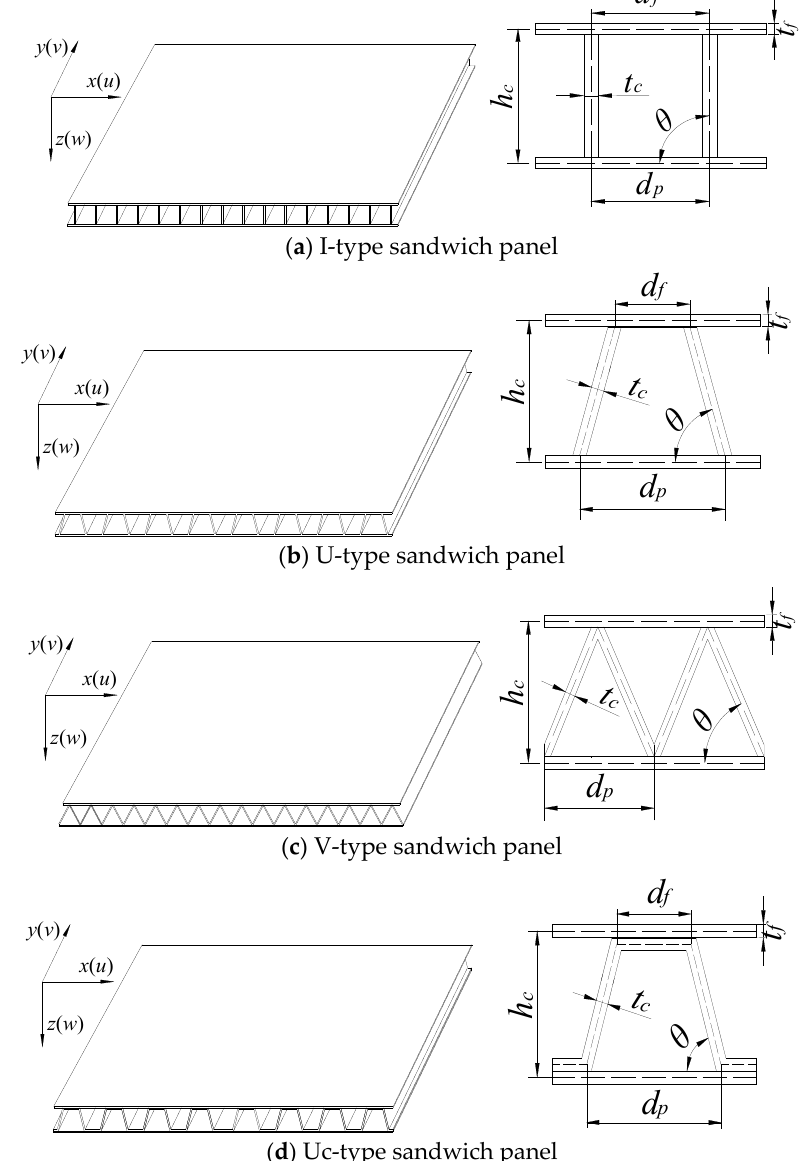
Figure 1. Metal sandwich structure.